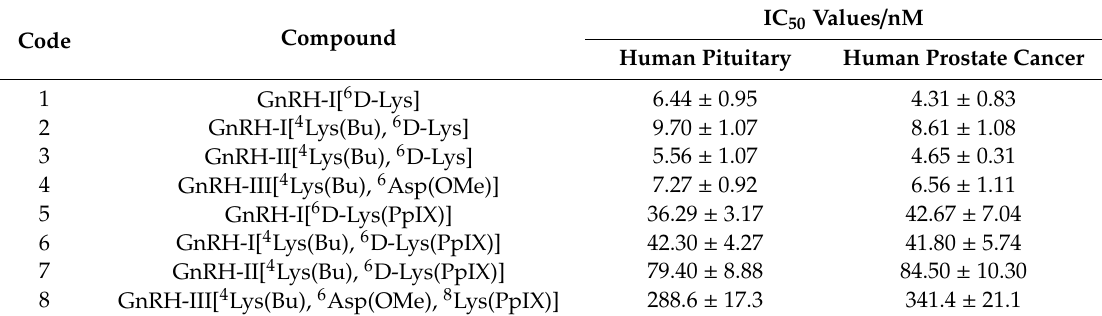
Table 2. Receptor binding potency of the GnRH analogs and the GnRH-PpIX conjugates measured by the inhibition of [ 125 I]-[ 6 D-Trp]-GnRH-I binding to the membranes of human pituitary and human prostate cancer cells.